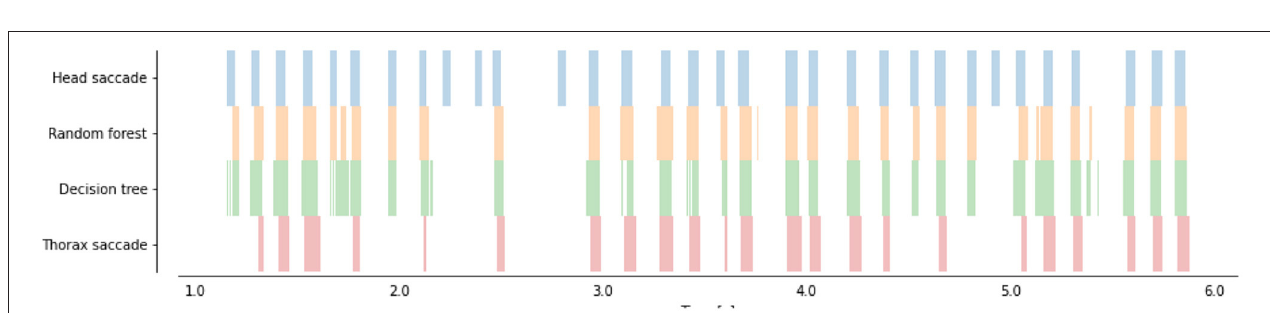
FIGURE 4 | Time course of head saccades (blue) and predicted head saccades (orange and green) from thorax angular velocity ω y ). Thorax saccades (in red) are extracted with a double thresholds (as in Figure 3 ). Two trained classifiers (a decision Tree, in green, and a Random Forest, in orange) were applied to the learning flight (which was not used for training) to predict head